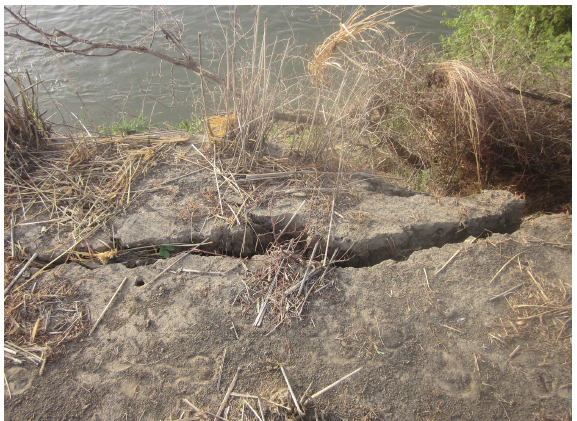
Figure 2. Amorce de déstabilisation d’une berge non loin de Ko- koumi, 9 ◦ 18 (cid:48) 22.76 (cid:48)(cid:48) N–12 ◦ 59 (cid:48) 43.99 (cid:48)(cid:48) E. Cliché : Félix Mbélé